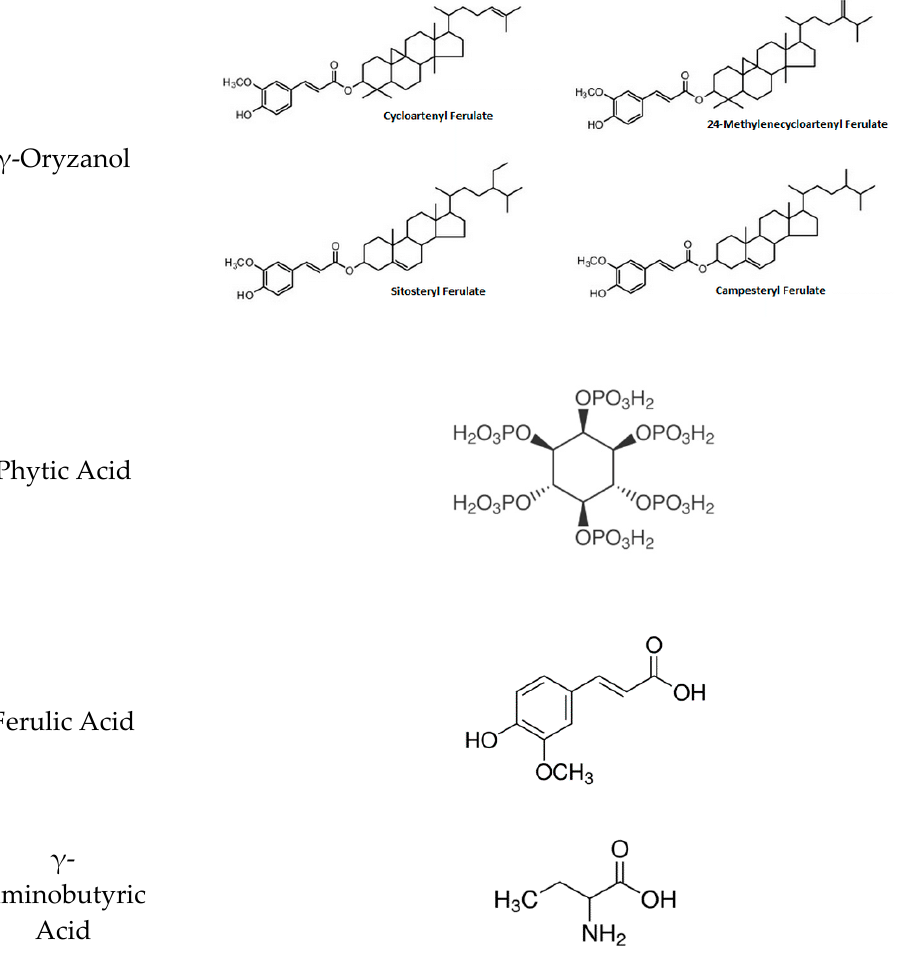
Figure 1. Chemical structure of rice bran